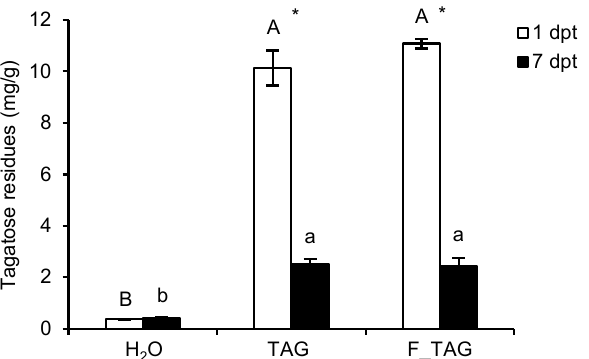
H2O T. TAG T. MCF T. Figure 1. Tagatose residues on tomato leaves. Tomato plants were treated with water (H 2 O), 5 g/L pure tagatose (TAG), or a formulated product that contained 5 g/L tagatose (F_TAG). Tagatose was assessed in leaf washing suspensions of H 2 O-treated, TAG-treated, and F_TAG-treated leaves collected at one (white bars) and seven (black bars) days post-treatment (dpt) and expressed per unit of leaf fresh weight (mg/g). The two-way analysis of variance (two-way ANOVA) showed no significant differences between the two experimental repetitions ( p > 0.05, three replicates per experiment), and data from the two experiments were pooled. Mean and standard error values of six replicates (each as a pool of 50 leaves collected from 20 plants) from the two experiments are presented for each treatment. Different uppercase and lowercase letters indicate significant differences among treatments at 1 dpt and 7 dpt, respectively, according to Tukey’s test ( p ≤ 0.05). For each treatment, significant differences between 1 dpt and 7 dpt are marked with an asterisk (*), according to the Student’s t -test ( p ≤ 0.05).